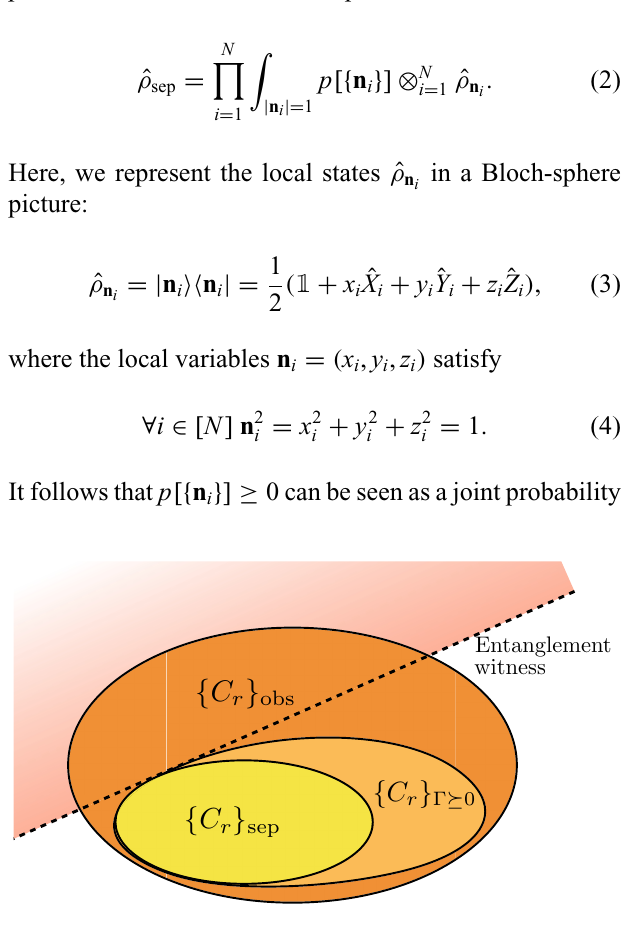
FIG. 1. Geometrical representation of the proposed entangle- ment detection framework. By arranging the observed data D ˆ ρ = } R { C as a vector, one can represent them as a point in a R - r r = 1 dimensional space. Among all valid quantum data (represented as the dark orange convex set), one can identify the separable set, namely the convex subset of data, which can be reproduced with a separable state (yellow set). We consider an efficient way to characterize a strict superset, corresponding to the data { C r } (cid:3) (cid:9) 0 compatible with a positive-semidefinite correlation matrix (cid:3) (light orange set). Such a set contains { C r } sep ; hence, if the data does not pass the (cid:3) (cid:9) 0 test, then D ˆ ρ necessarily lies outside of the separable set, constituting a proof of entanglement. The method also provides an entanglement witness, i.e., a hyperplane separating the observed data from the separable